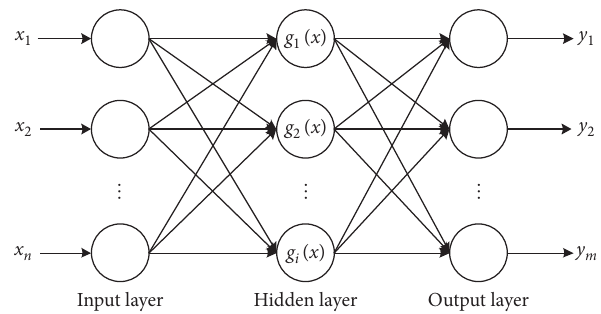
Figure 1: Wavelet neural network model